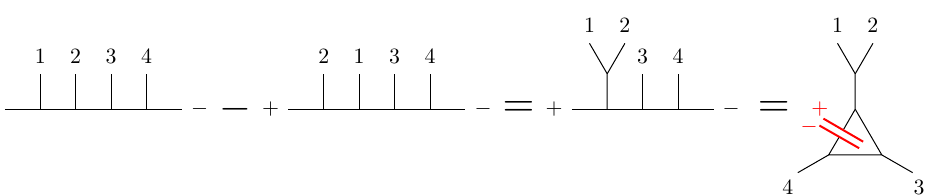
Figure 5 . Graphic depiction of the Jacobi identity giving rise to the triangle numerator in eq. (4.2a). Explicitly, we check that the di(cid:11)erence between the left-hand and right-hand sides in the expression above either scales for a rescaling of the loop momentum or is a linear com- bination of terms that scale; equivalently, that there is no propagator factor of the